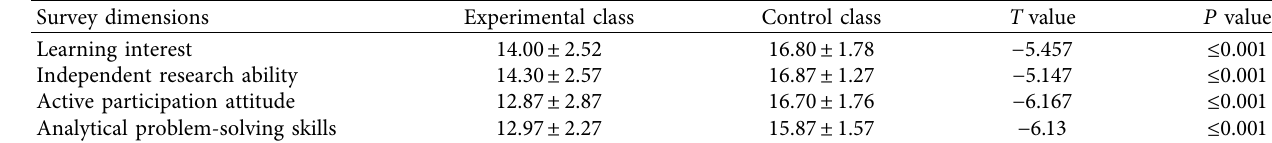
Table 3: Test of martial arts learning situation of students in experimental class before and after the experiment.